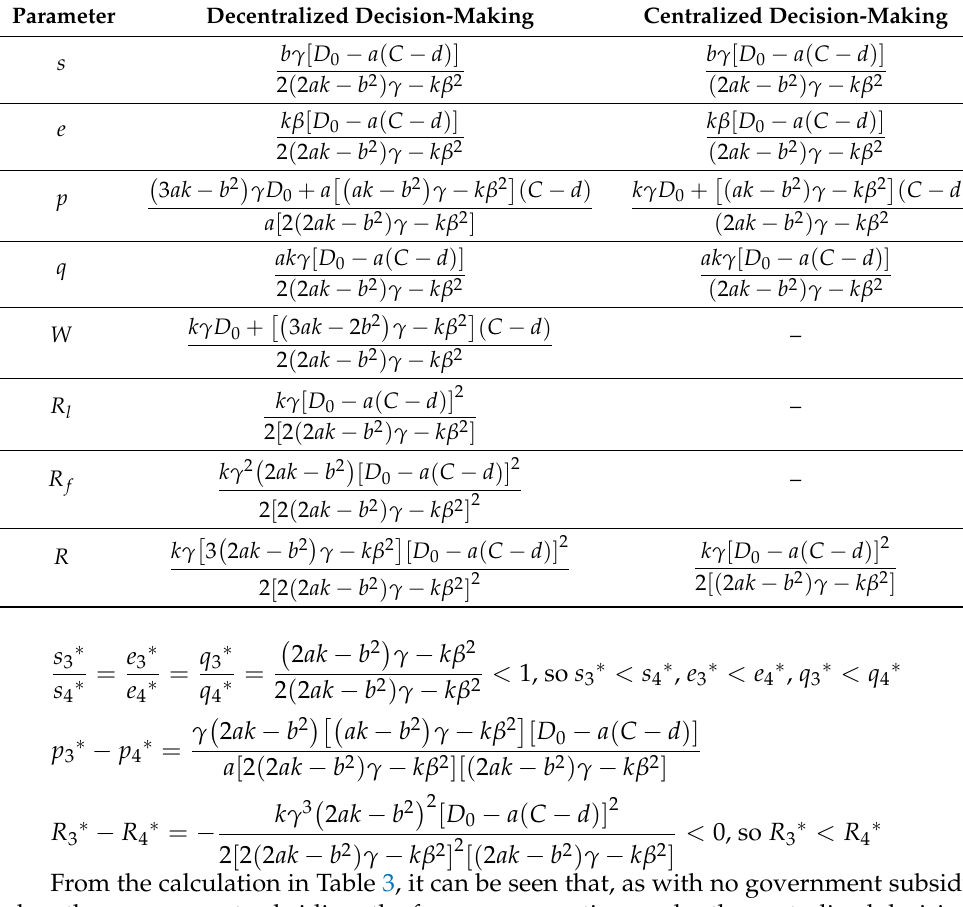
Table 3. Variable values and profits of different decision-making modes.